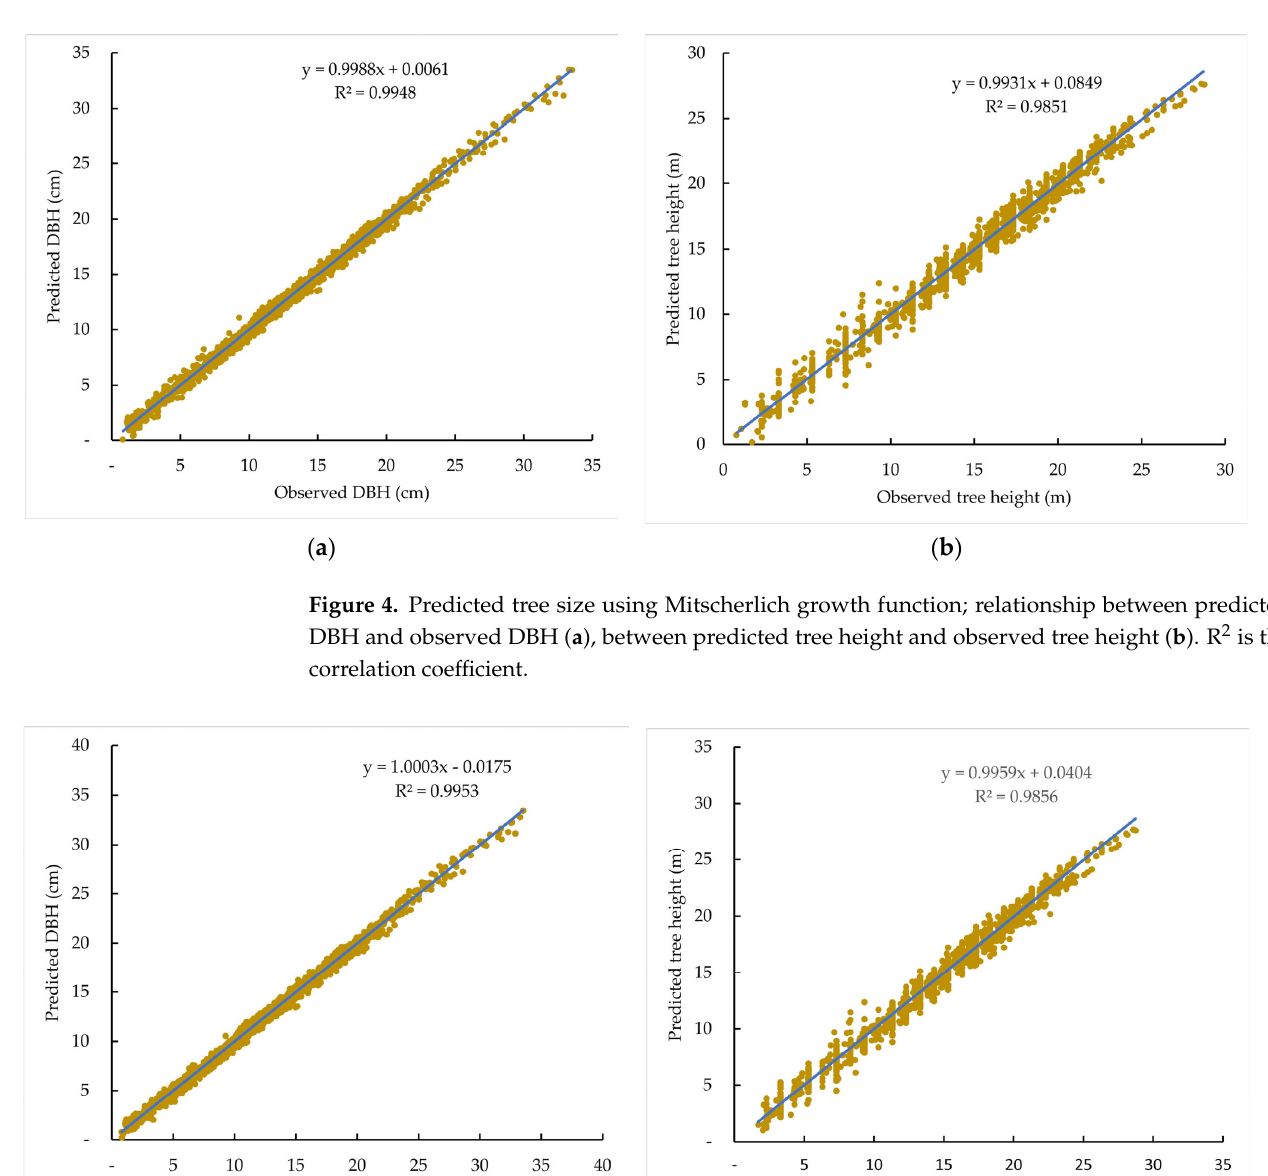
6 of 14 Table 1. Individual tree growth curve parameters of Mitscherlich growth function. RMSE: root mean square error. A (upper limit of tree growth) , k (curvature of tree growth curve or parameter related to growth rate) and (cid:1872) (cid:2868) (time lag of tree growth) are fitted tree growth curve parameters. Site